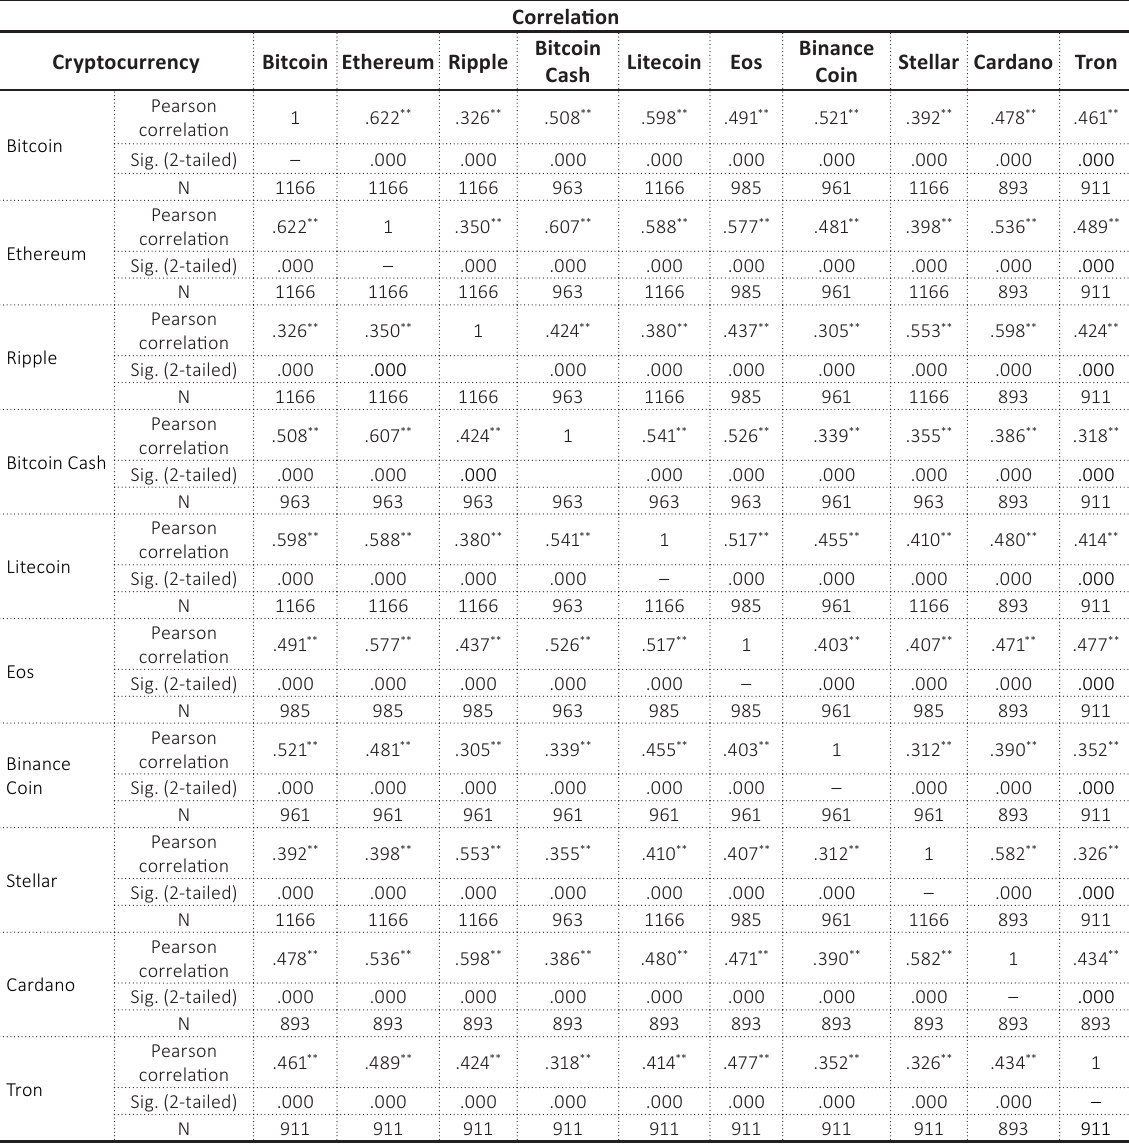
Table 1. Pearson correlation coefficients between cryptocurrency pairs for the entire period (daily